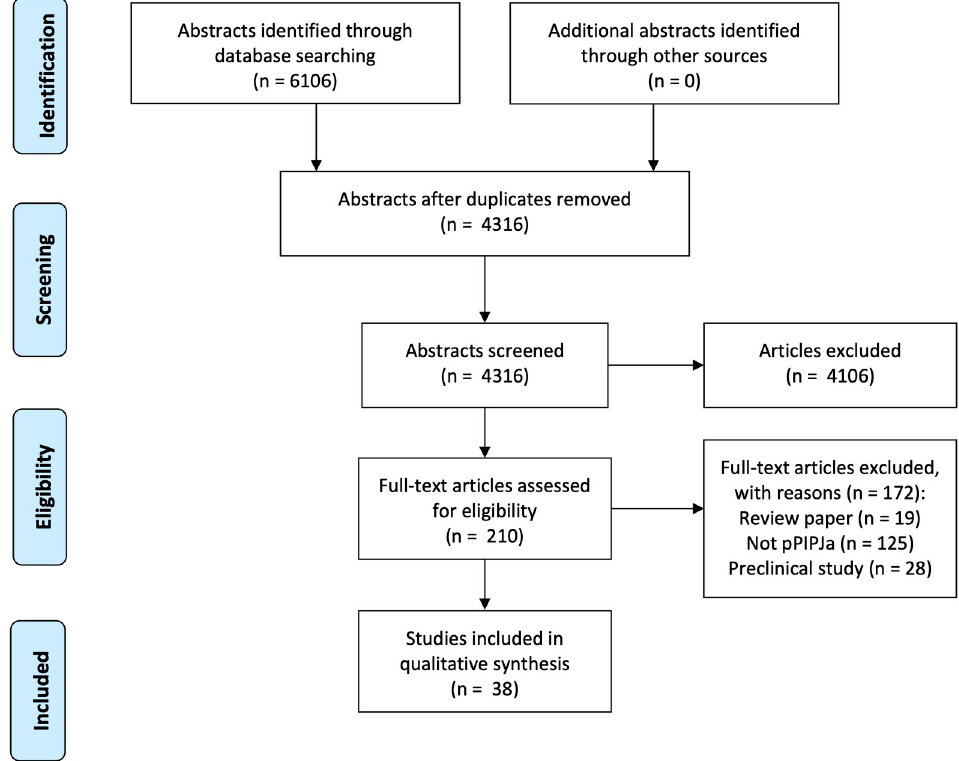
Fig 1. Preferred Reporting of Systematic Reviews and Meta-Analyses (PRISMA)